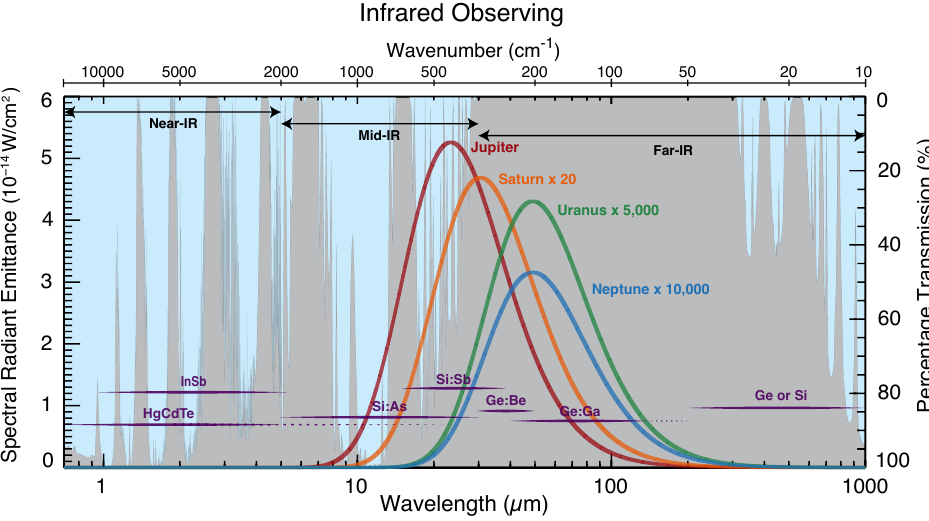
Figure 1. Idealized blackbody emittance of the giant planets compared to the telluric atmospheric transmission and typical detector sensitivities across the infrared. The assumed boundaries of the near-, mid-, and far-infrared regions are indicated. Colored curves show the black body spectral radiant emittance for the effective temperatures of the giant planets, accounting for their distances, scaled and labeled for clarity. Jupiter and Saturn peak in the mid-infrared, while Uranus and Neptune peak in the far-infrared. The atmospheric transmission is indicated by the blue–gray interface varying between 100% (full transmission) and 0% (total attenuation) from the top of the atmosphere down to a surface altitude of 2640 m (corresponding to the altitude of the Very Large Telescope (VLT) at Cerro Paranal, with a precipitable water vapor (PWV) of 1.66 mm at an air mass of 1.15 [5,6]). Characteristic ranges for various thermal detectors are shown in purple